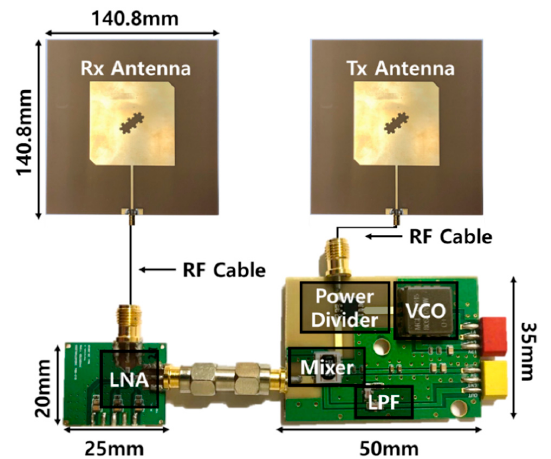
Figure 8. Photograph of the 915-MHz CW Doppler radar sensor including front-end module, LNA module, and two antennas with a